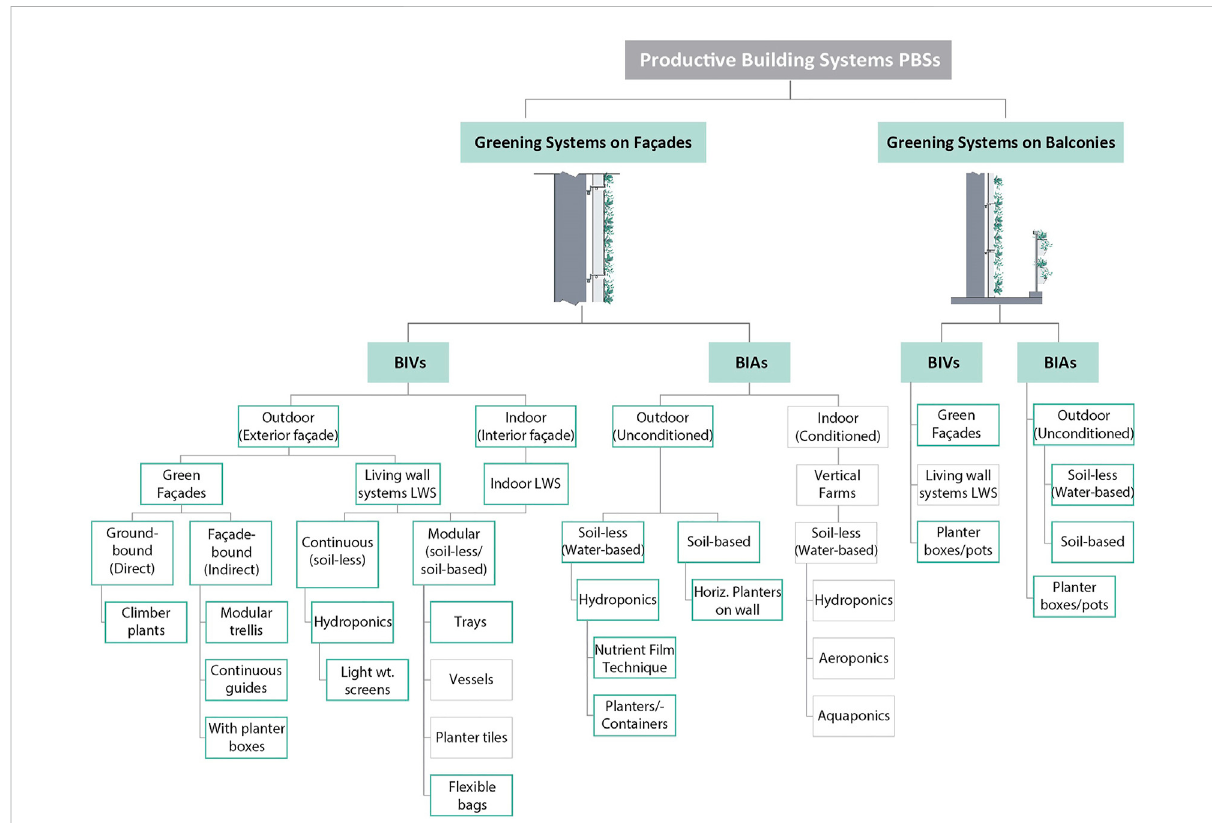
FIGURE 4 Inventoryofgreeningsystems(BIVsandBIAs)onfaçadesandbalconies,compilingthetypesandclassi fi cationsidenti fi edfromassessedstudies and reports to create the body of classi fi cation (all boxes). Structured based on (Perini et al., 2011; Gould and Caplow, 2012; GWG, 2013; DEPI, 2014; Raji et al., 2015; Tablada and Kosoric, 2017; Besir and Cuce, 2018) with additions. Systems existing in the Egyptian market are highlighted by the green-borderedboxes.Forbalconies,allsystemscanbeinstalledontherailing/parapet,andtheplanterboxes/potscanalsobelaidonthe fl oor. PBSs: Productive Building Systems, BIVs, Building-Integrated Vegetation systems; BIAs, Building-Integrated Agriculture Systems; LWS, Living Wall System; NFT, Nutrient Film